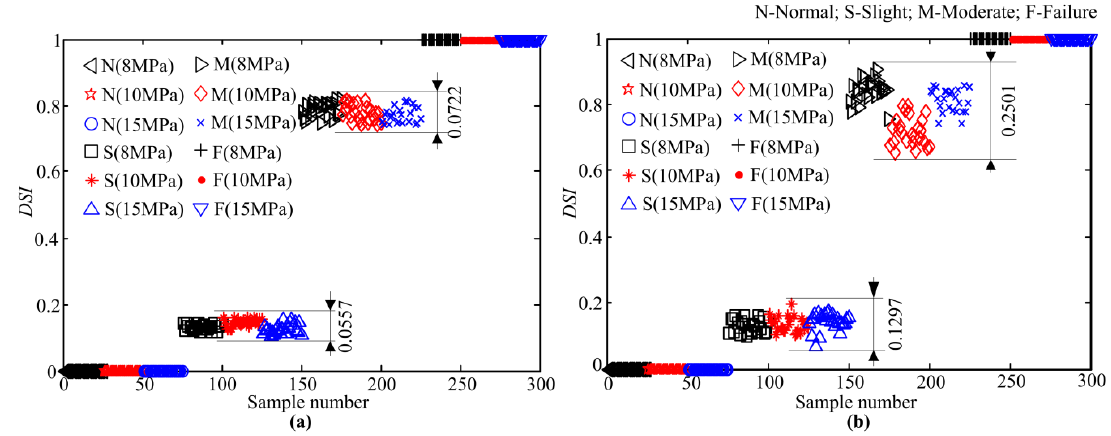
Figure 11. The degradation status index (DSI) sequences obtained from the Gaussian mixture model (GMM) using ( a ) EMD3 and ( b ) EMD2.